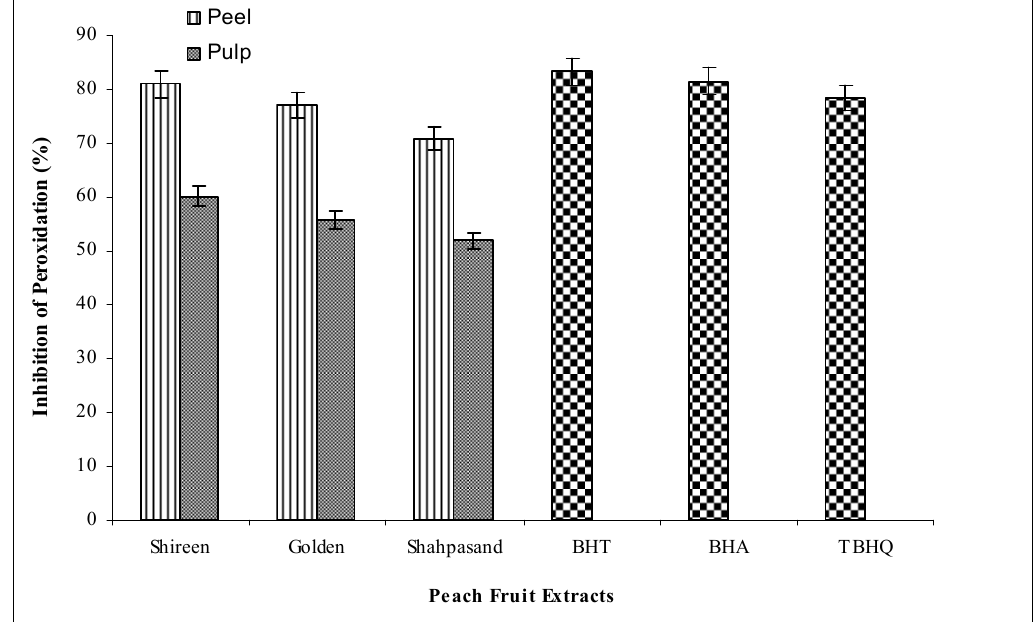
BHT: butylated hydroxytoluene; BHA: butylated hydroxyanisole; TBHQ: tertiary butylated